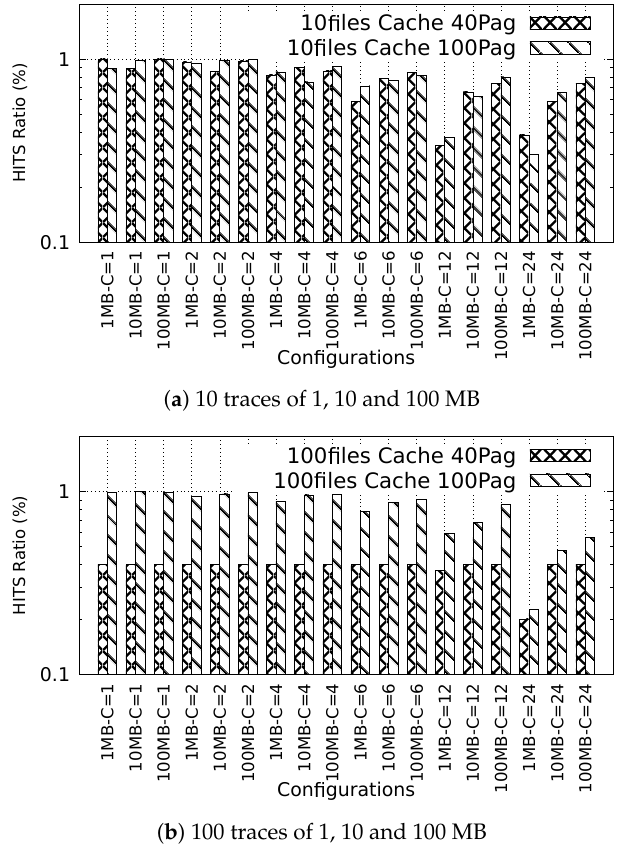
Figure 6. Percentage of hits ratio in the cache observed when exchanging data between two fog